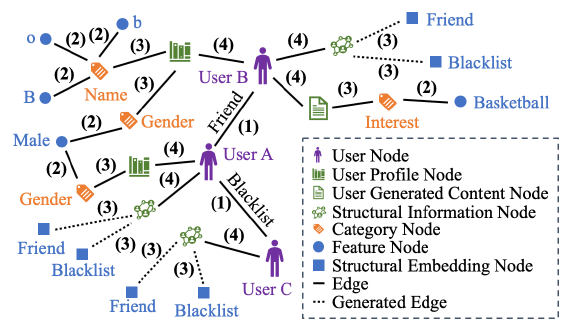
Figure 1. Example of a heterogeneous social network